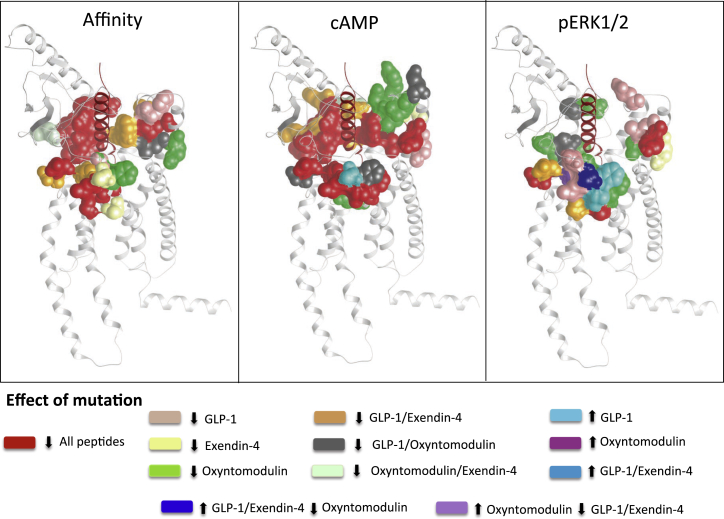
3D Model Illustrating GLP-1R ECL Loop Residues that Are Globally or Selectively Important for GLP-1, Oxyntomodulin, and Exendin-4Based on statistical significance (p < 0.05) of effect when mutated to alanine, experimentally observed effects on peptide affinity and efficacy can be mapped onto the molecular model to clearly highlight similarities and differences between the three peptide agonists. Residues highlighted in red reduce function (affinity [A] or efficacy [B and C]) of all three peptides, those in pink selectively reduce GLP-1 only, those in yellow selectively reduce exendin-4 only, and those in green selectively reduce oxyntomodulin only. A large number of residues are important for both GLP-1 and exendin but not oxyntomodulin, and these are highlighted in orange. Other colors represent either enhanced function (GLP-1 only/oxyntomoduin only or GLP-1 and exendin) or existence of opposite effects when mutated on oxyntomodulin compared to GLP-1 and exendin-4.